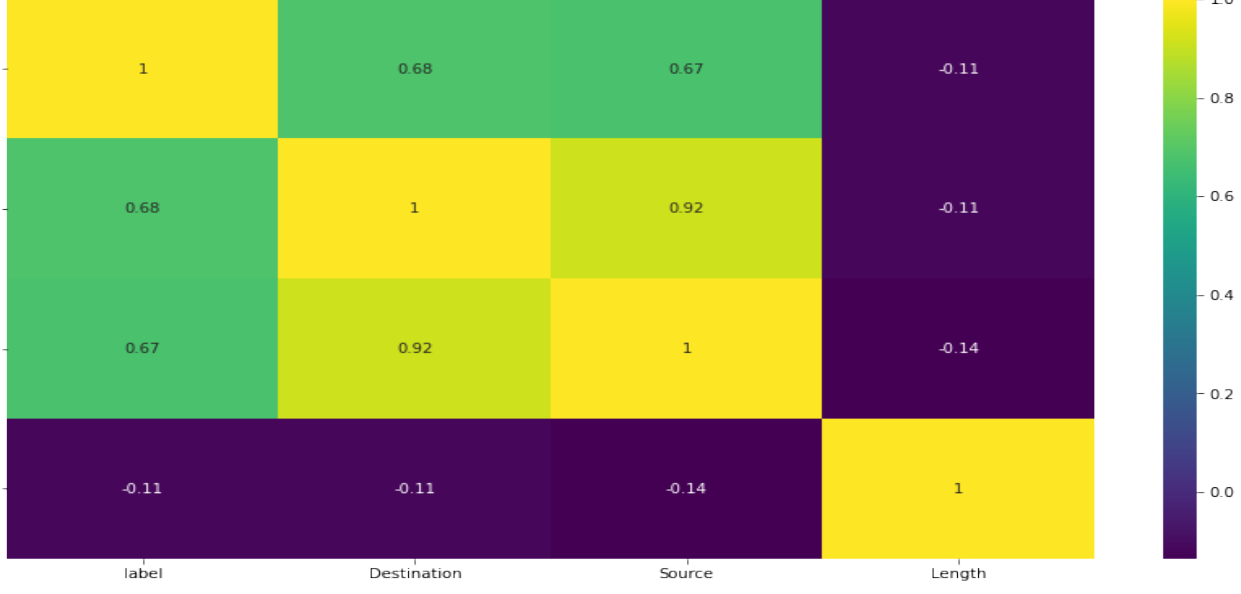
Figure 13. The correlation coefficients of the ICS datasets.